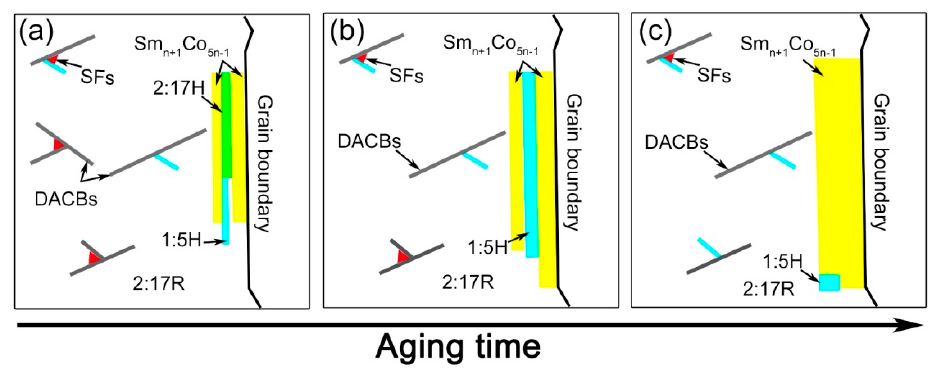
Figure 8. Schematic illustrations of the microstructure of a grain boundary derived from the TEM characterizations for Sm 25 Co 46.9 Fe 19.5 Cu 5.6 Zr 3.0 magnets. Solution-treated ( a ), aged for 0.5 h at 810 °C ( b ), and the final magnet ( c ).